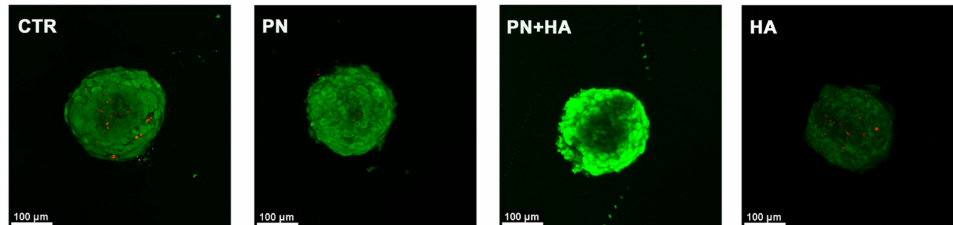
Figure 4. Microphotographs of spheroids under different culture conditions after eight days of culture at Confocal Microscope after labeling with calcein-AM (green) or propidium iodide (red). Magnification = 10 ×